Question: Draft a figure caption describing what is shown.
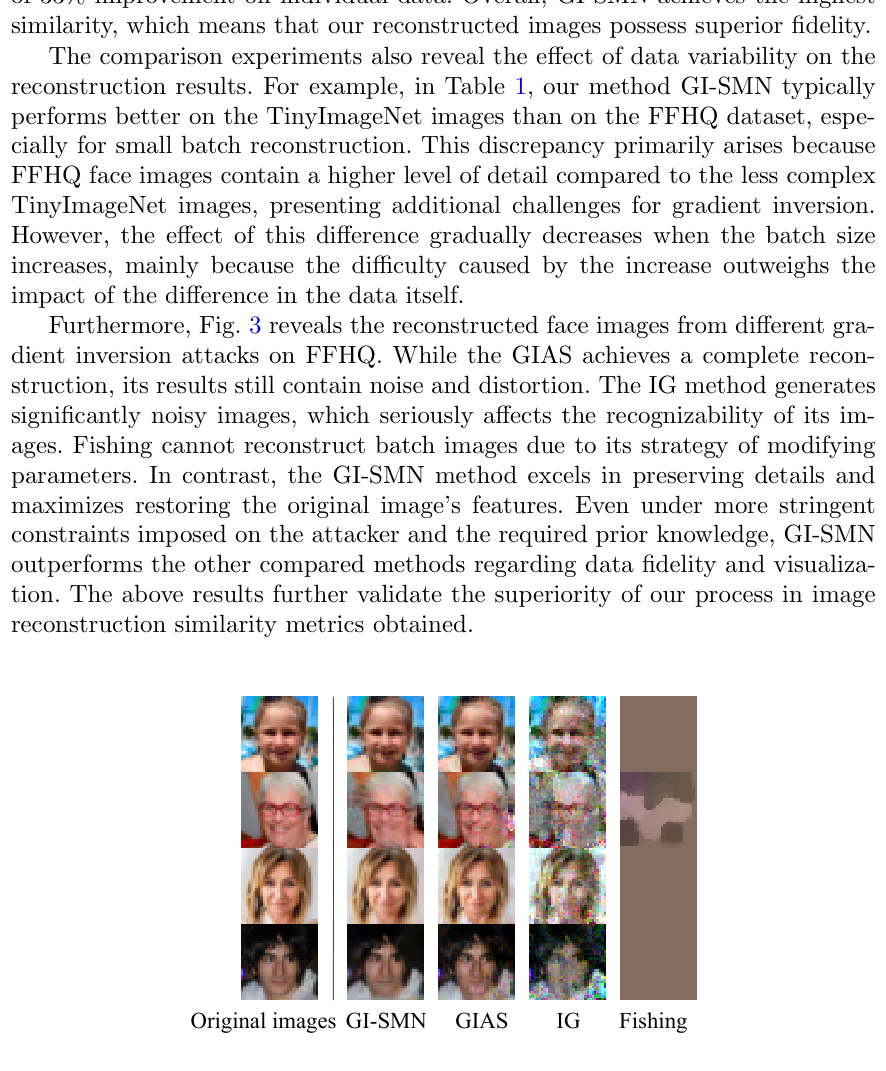
Answer: A comparison of images reconstructed by GI-SMN and state-of-the-art gradient inversion attacks with a batch size of four on FFHQ. The left column represents images from FFHQ, and the rest denote images constructed by dif- ferent gradient inversion attacks.